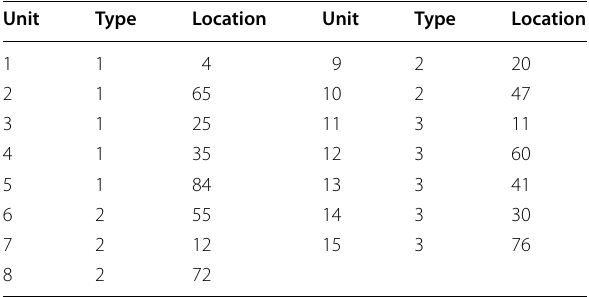
Table 5 DG units type and location in TPC distribution